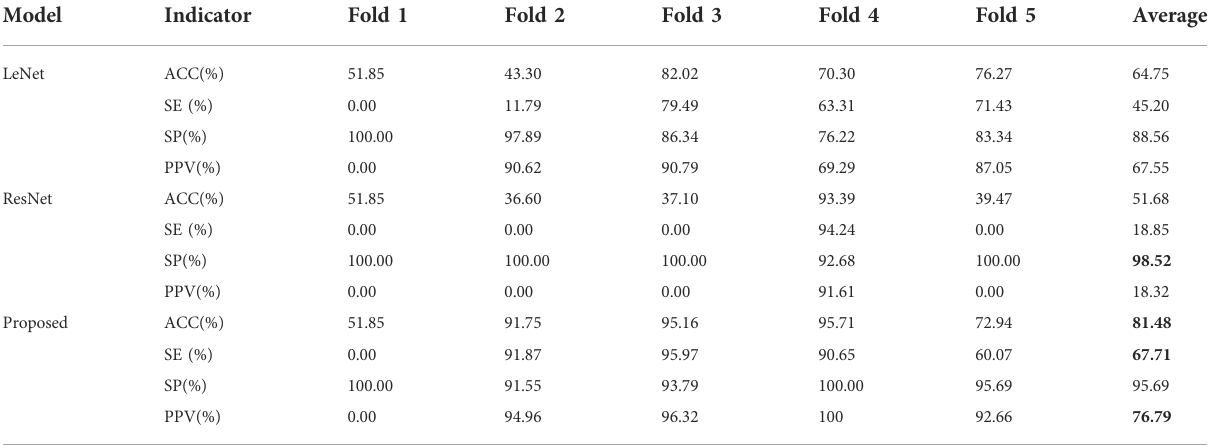
TABLE 4 Inter-patient prediction performance of the fi ve-fold cross-validation model. Model